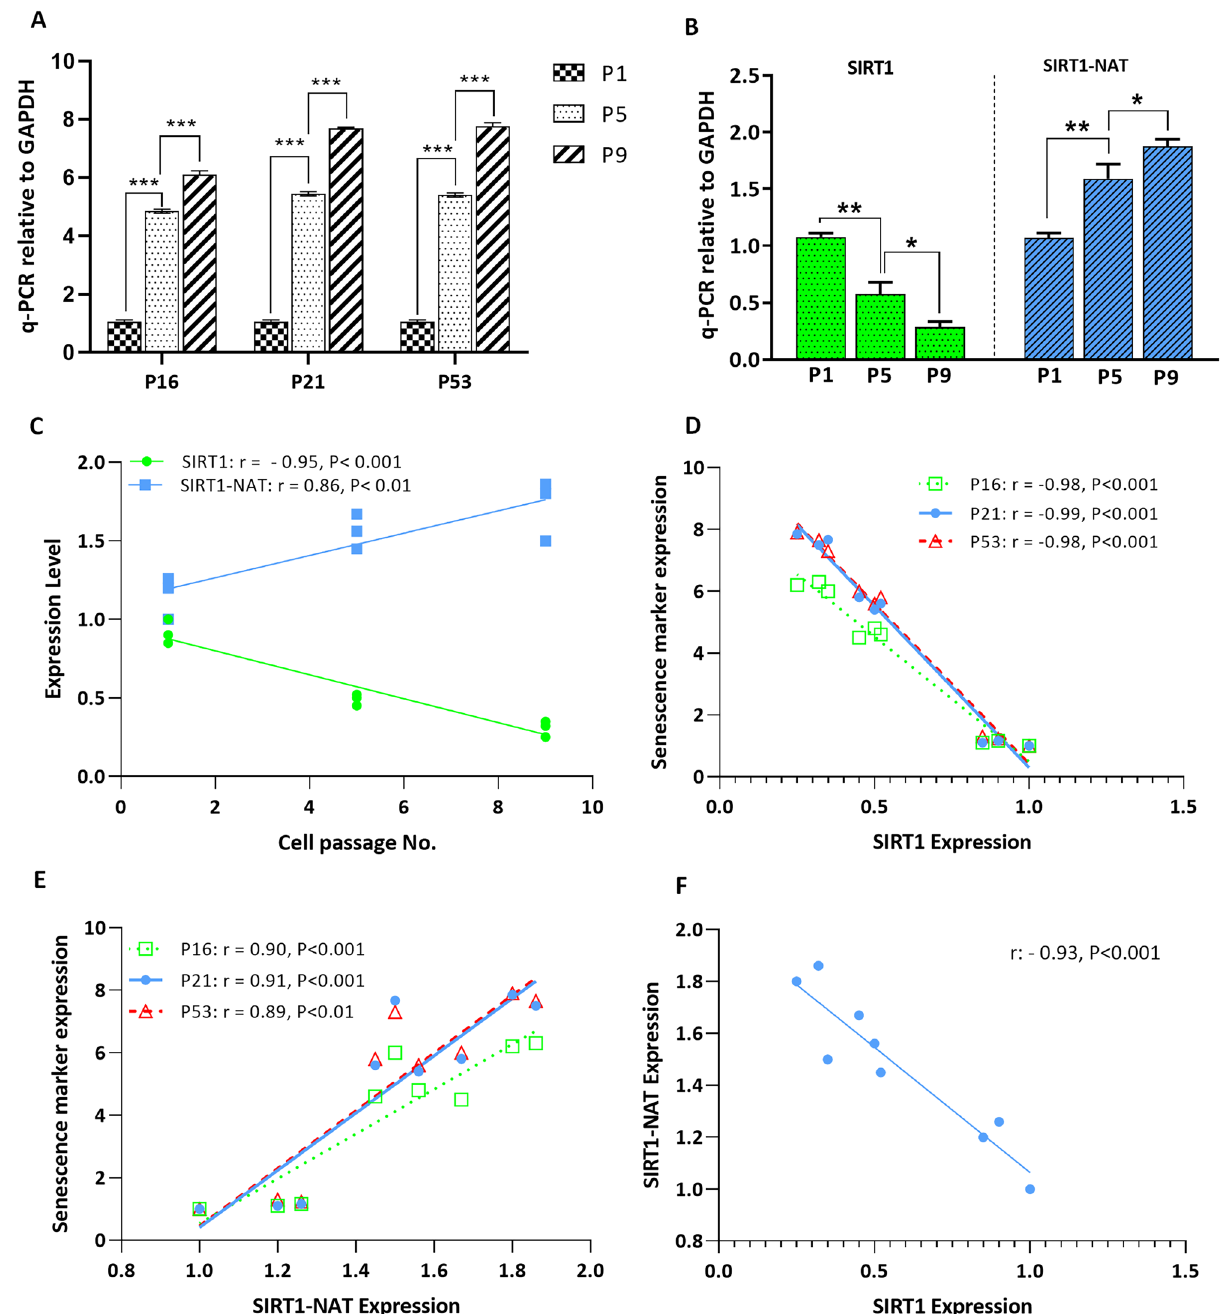
Figure 1. Reverse correlations of SIRT1 and SIRT1-NAT upon increasing passage numbers of MSCs. ( A ) Bar graphs showing the relative expression levels of senescence marker genes P16, P21 and P53 in MSCs at passages 1,5, and 9 determined by RT-qPCR. The expression levels of senescence markers were increased upon subculture of MSCs. ( B ) Bar graphs showing the relative expression levels of SIRT1 mRNA and SIRT1-NAT in MSCs at passages 1, 5 and 9 determined by RT-qPCR. Upon increasing passage number, the expression of SIRT1 was reduced and that of SIRT1-NAT was enhanced. ( C ) Scatter plots showing the negative correlation of SIRT1 and the positive correlation of SIRT1-NAT with passage number of MSCs. ( D ) Scatter plot showing the negative correlation between the expression levels of senescence marker genes and that of SIRT1. ( E ) Scatter plot showing the positive correlation between the expression levels of senescence marker genes and that of SIRT1-NAT. ( F ) Scatter plot showing the negative correlation of SIRT1 and SIRT1-NAT with each other. Data are mean ± SD (n = 3). * p < 0.05, ** p < 0.01, *** p <